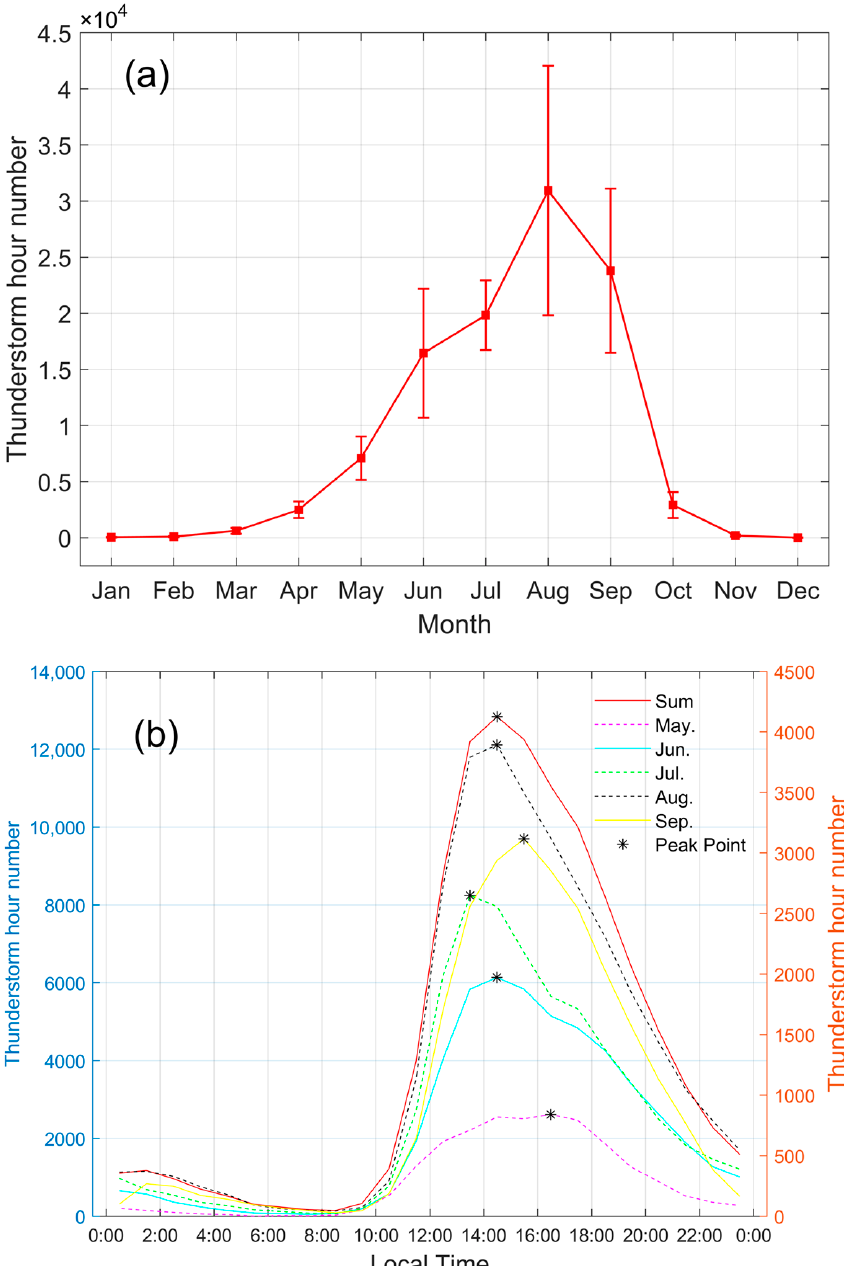
Figure 4. Monthly variation ( a ) with error bars and diurnal variation ( b ) in thunderstorm activity over the QTP.